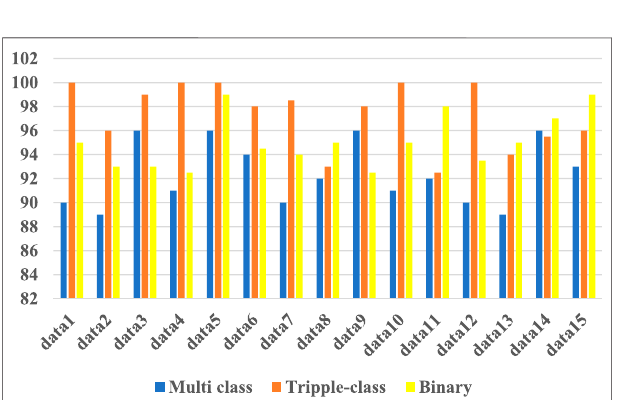
FIGURE 10 | Recall across 15 multiple-class, 15 trinary-class, and 15 binary datasets.